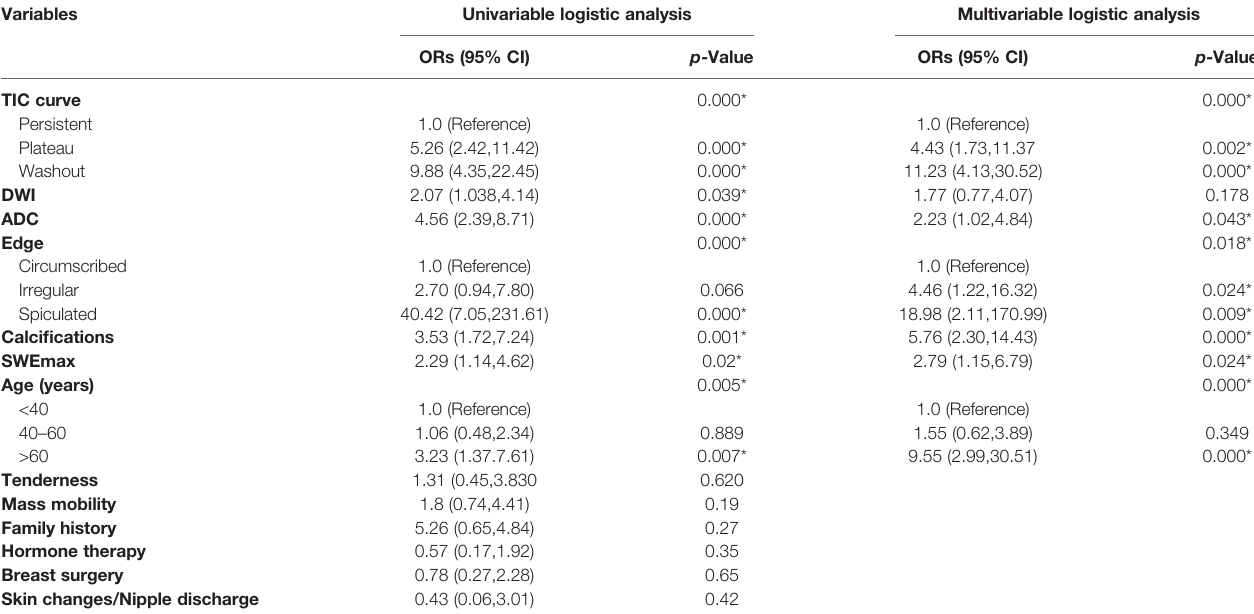
TABLE 3 | Differential regression analysis of imaging and clinical indexes of benign and malignant lesions of class 4A (only showing the difference of imaging indexes with statistical signi fi cance). Variables